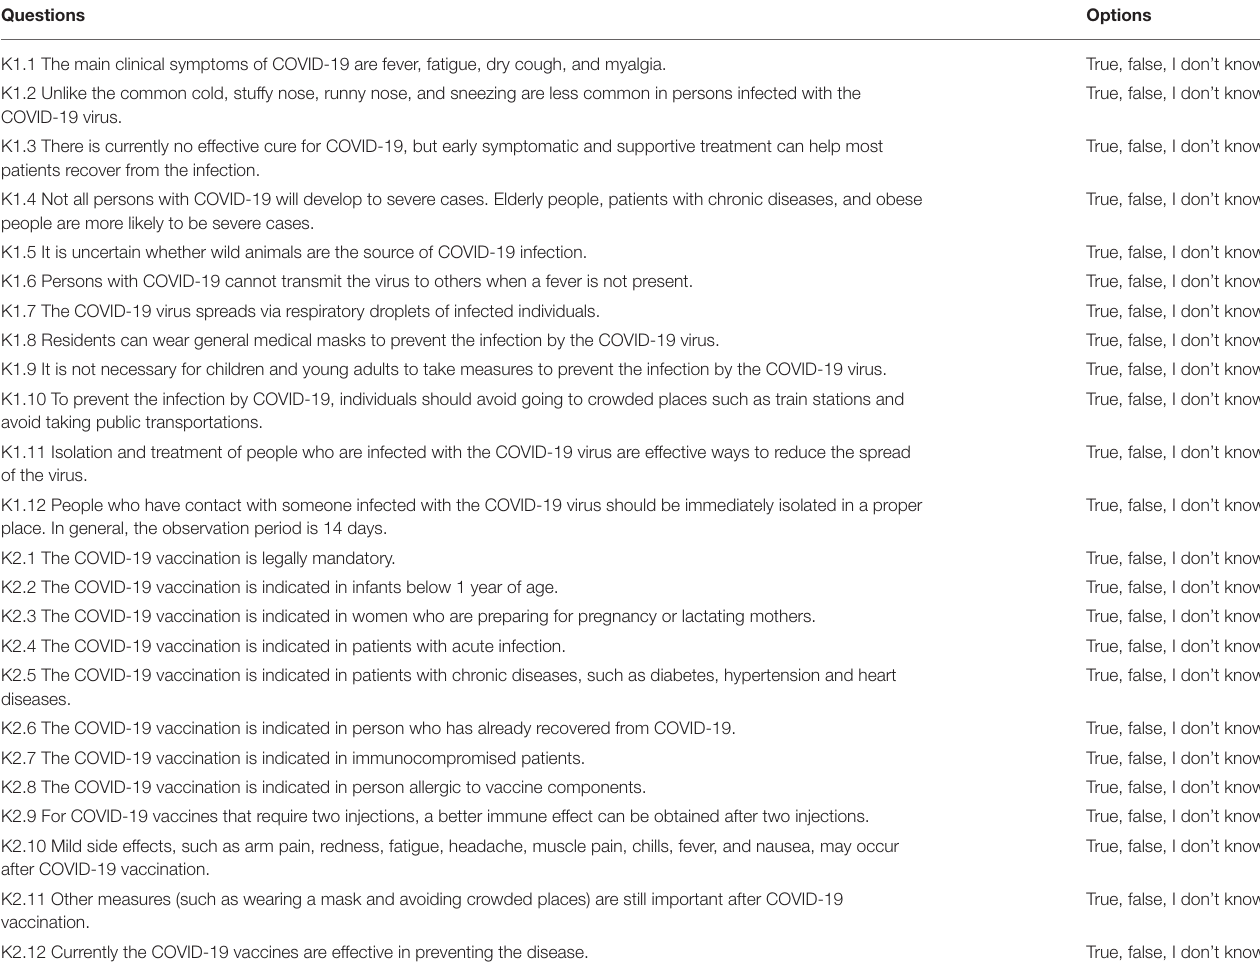
TABLE 1 | Questionnaire of knowledge toward COVID-19 disease and